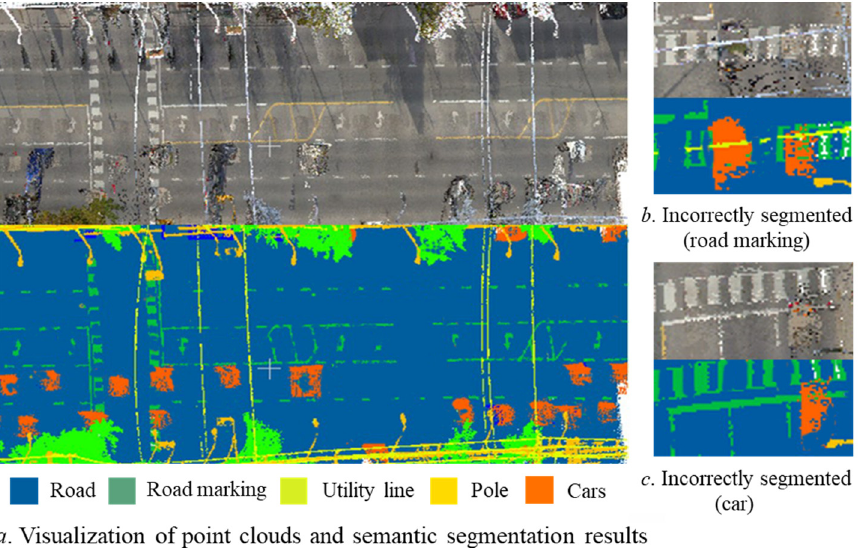
Figure 5. Comparison between colored point clouds and predicted segmentation results (Toronto- 3D).